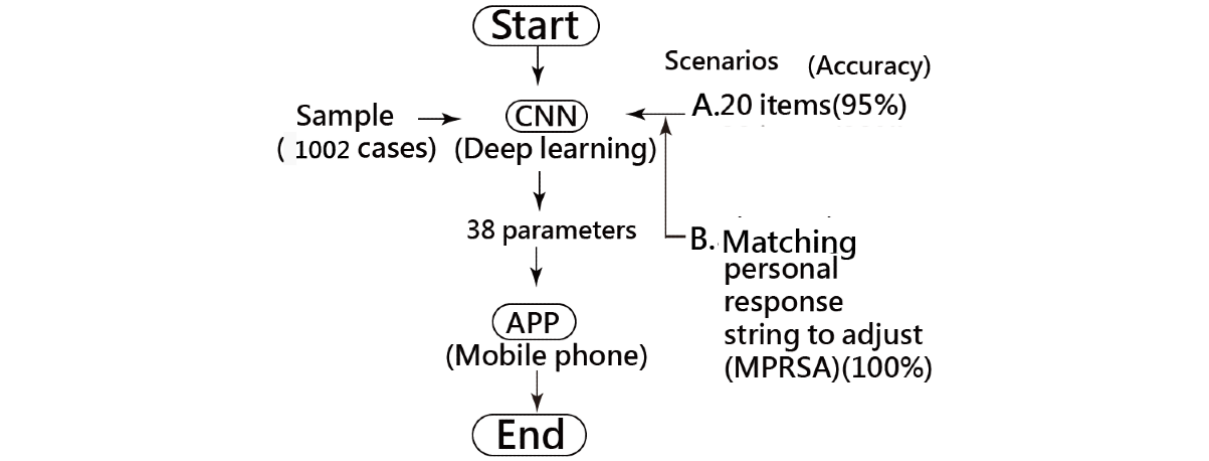
Figure 2. Study flowchart. CNN: convolutional neural network; MPRSA: matching personal response scheme to adapt for the correct classification in the